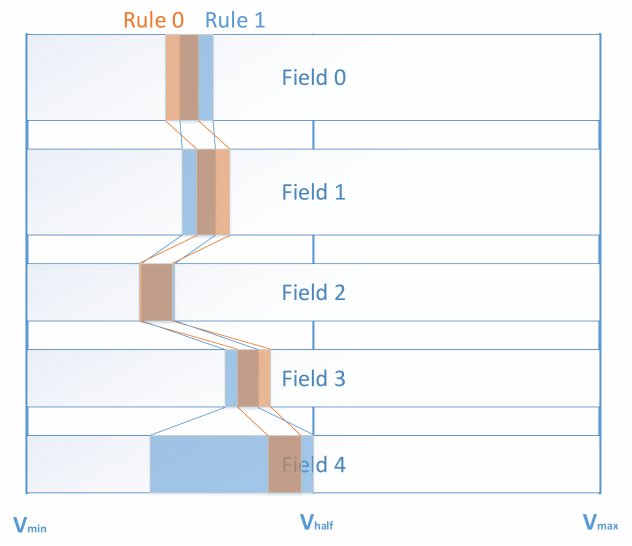
Figure 1. An example of Two-small